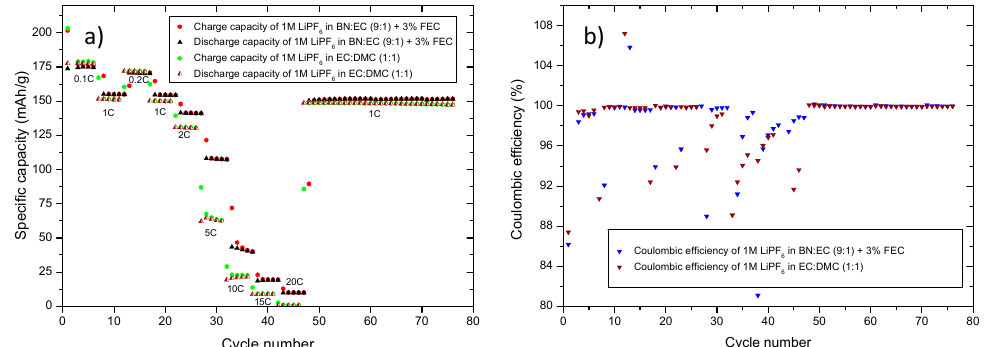
Figure 1. Temperature dependent conductivity measurements of 1M LiPF 6 in EC:DMC (1:1), 1M LiPF 6 in BN:FEC (1:1) and 1M LiPF 6 in BN:EC (1:1), in the temperature range from − 40 to 60 °C.